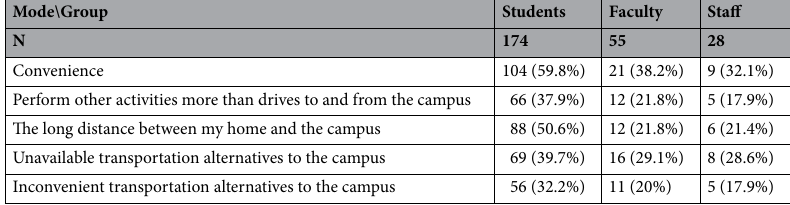
Table 7. Reasons for choosing a private car (fuel, electric/hybrid).